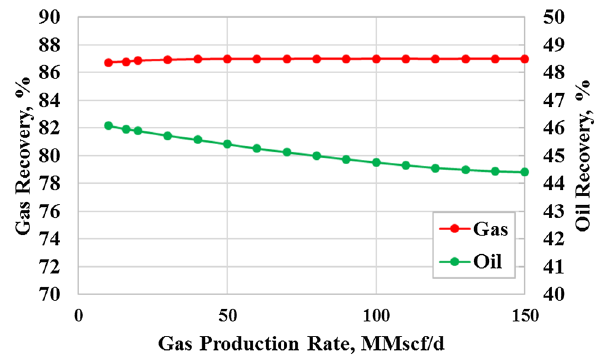
Fig. 21 Gas and oil recoveries for different gas production rates